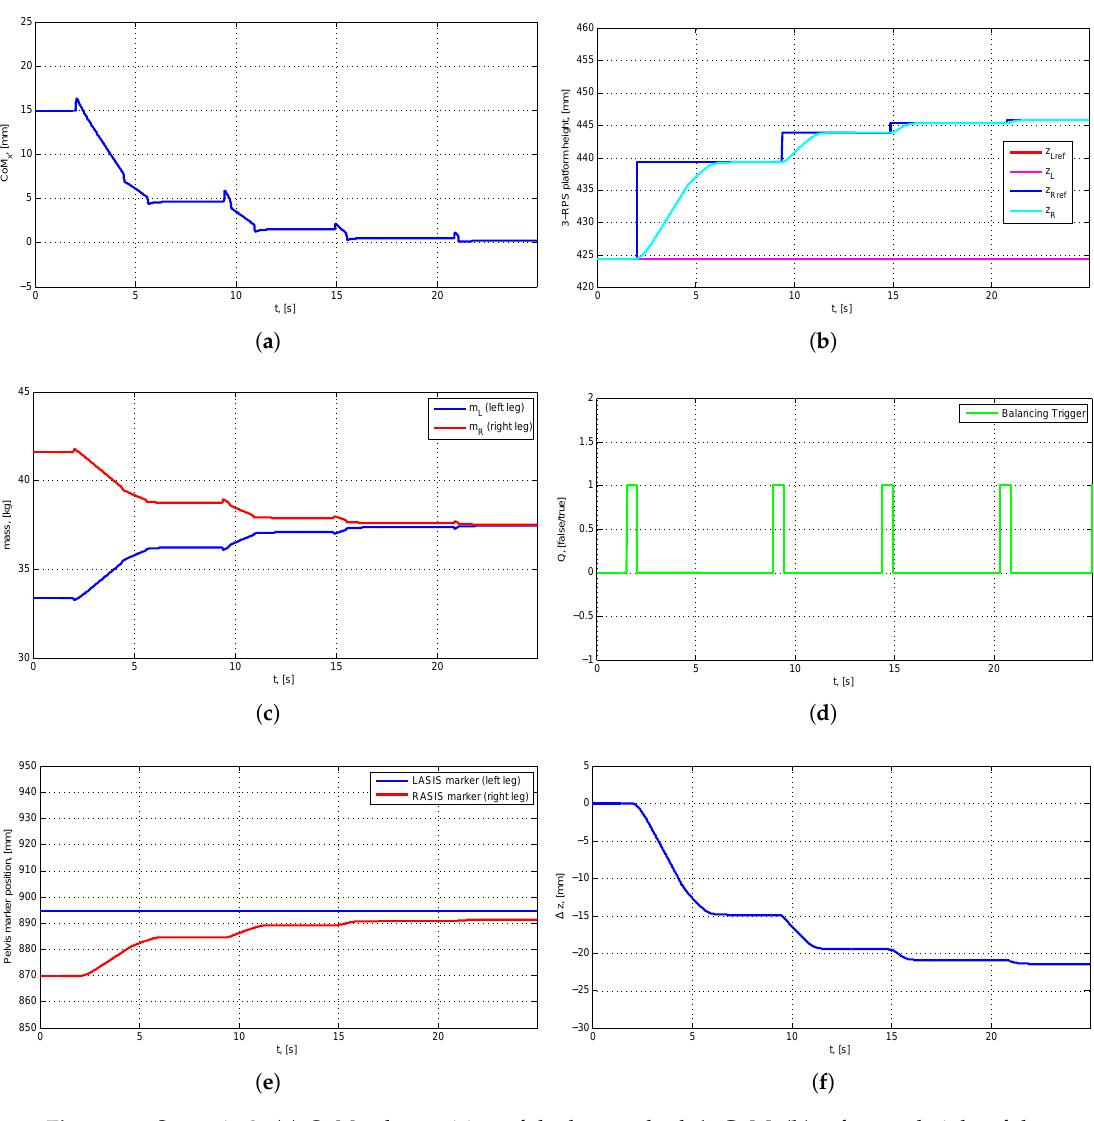
Figure 13. Scenario 2: ( a ) CoM x , the position of the human body’s CoM; ( b ) reference height of the left ( z Lref ) and right ( z Rref ) force plate, current height of the left ( z L ) and right ( z R ) force plate; ( c ) the load on the left ( m L ) and right ( m R ) leg; ( d ) the balancing trigger signal ( Q ) marking the start of a new HBBA iteration; ( e ) position of the LASIS and RASIS markers, which are located on the pelvis; and ( f ) left and right force plate height difference ( ∆ z ), which corresponds with the LLD evaluation ( ∆ l ) in the HBBA’s final